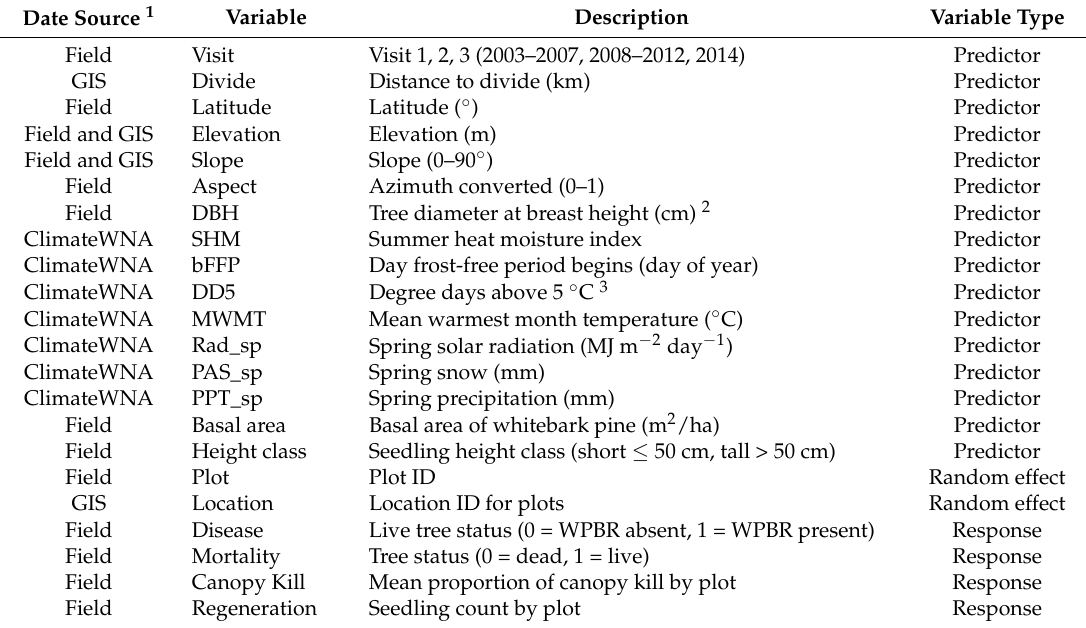
Table 1. Predictor and response